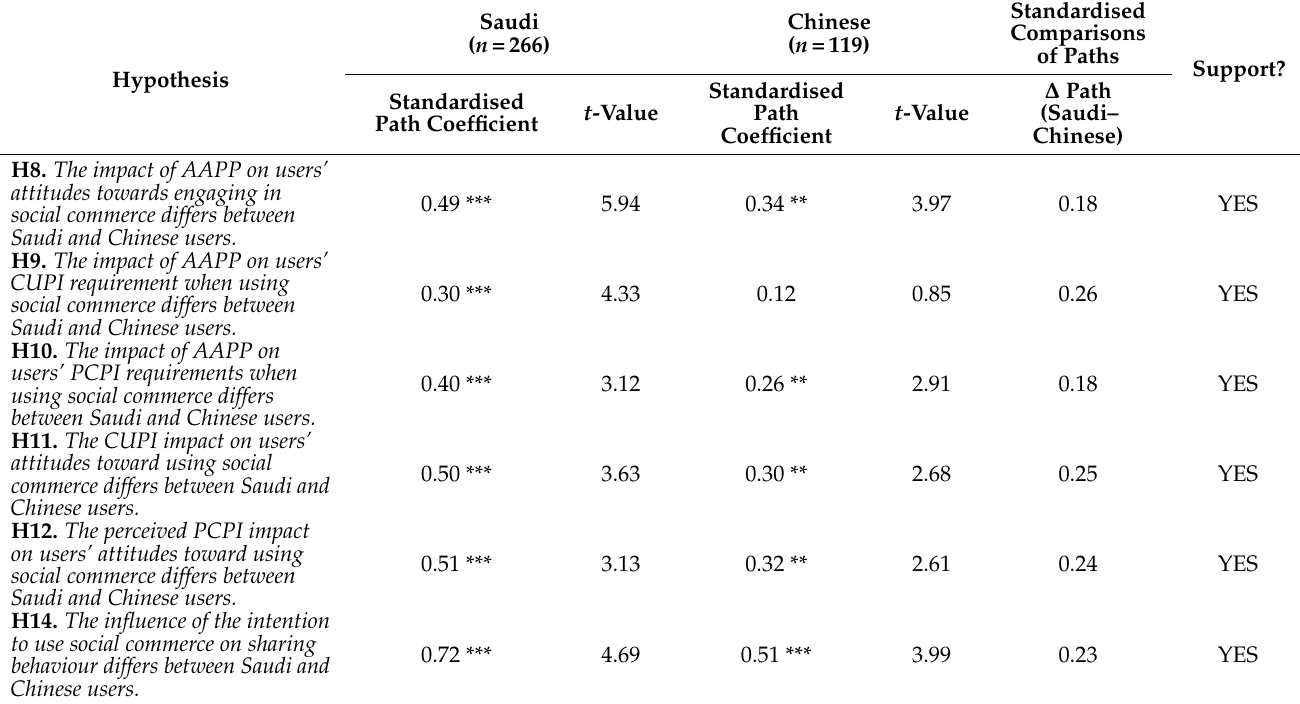
Table 7. Standardised comparisons of paths between Saudi and